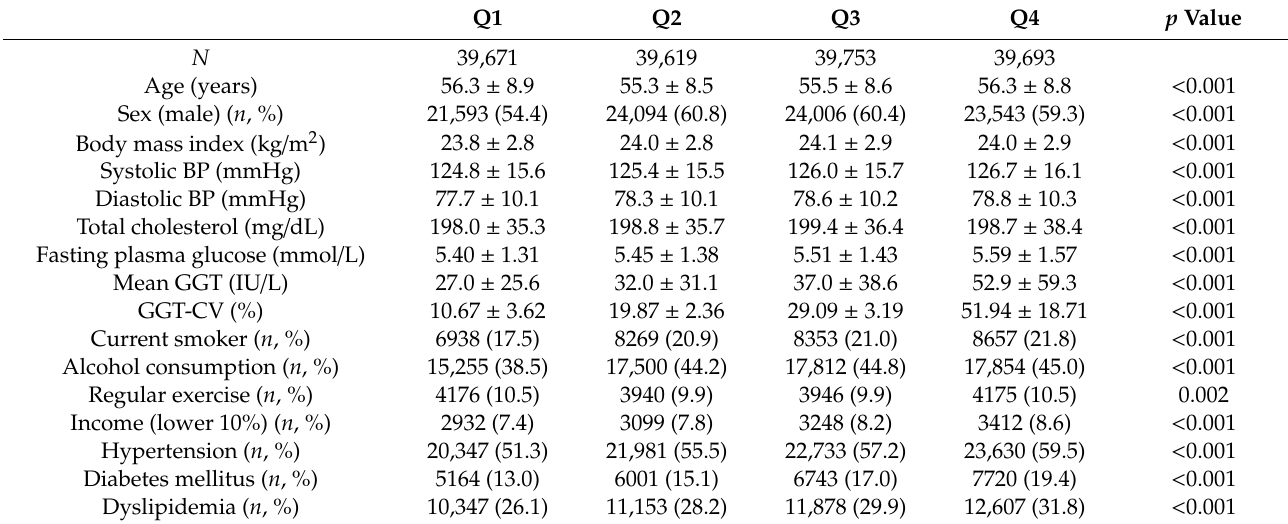
Table 1. Baseline characteristics of participants according to the γ -glutamyltransferase (GGT) variability (coe ffi cient of